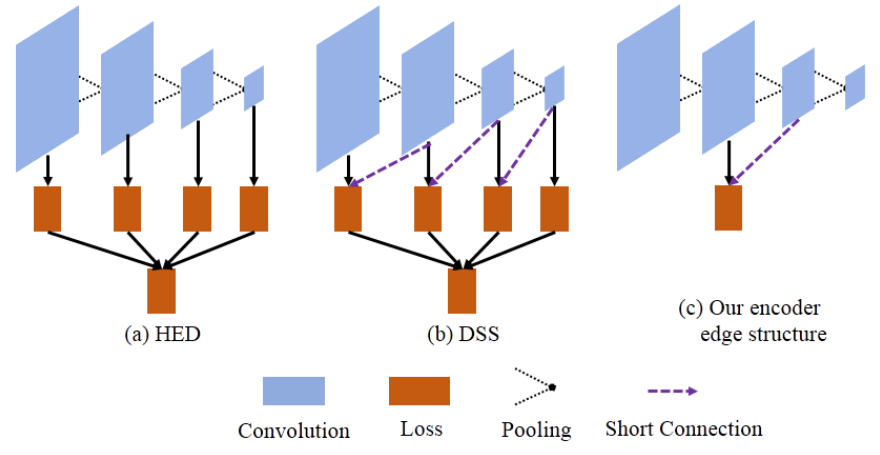
Figure 4. Illustration of different architectures. HED [29] and DSS [52] have several side output losses and one fuse loss. Our edge structure is much